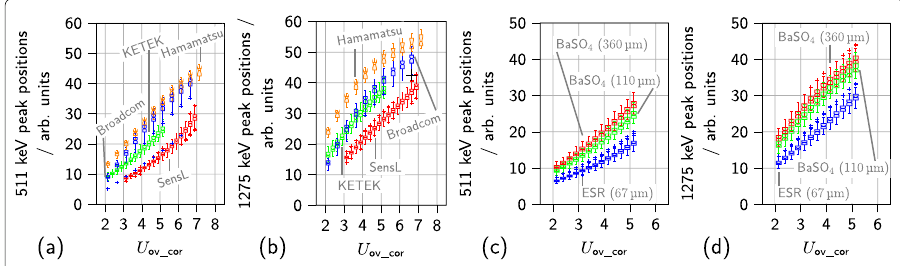
Fig. 4 Spread in gain for 128 ASIC channels coupled to SiPM arrays. A geometry of five NEMA cubes ( 22 Na sources) with a total activity of approximately 3 MBq is employed. a Position of the 511-keV peak in the energy value spectrum for different SiPM types. b Position of the 1275-keV peak in the energy value spectrum. Measurements were conducted using 110 μ m BaSO 4 as segmentation layer and SiPM arrays from Broadcom, KETEK, SensL, and Hamamatsu. c Position of the 511-keV peak in the energy value spectrum for different segmentation layers. d Position of the 1275-keV peak in the energy value spectrum for different segmentation layers. Measurements were conducted with two KETEK PA3325-WB-0808 SiPM arrays. All positions are plotted against the applied offset-corrected overvoltage U ov_cor